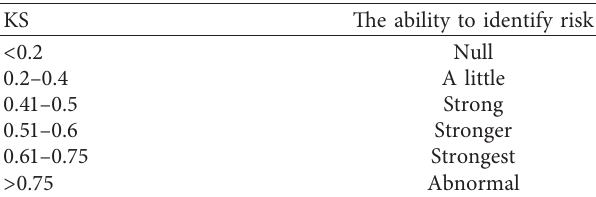
Figure 2: KS curve graph. Table 5: KS value and model customer identification ability.